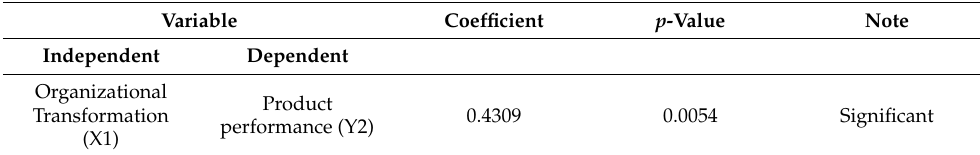
Table 5. Results of Hypothesis Testing for Total